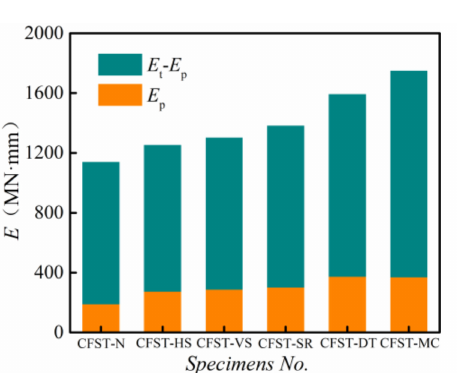
Figure 12. Cumulative energy dissipation of